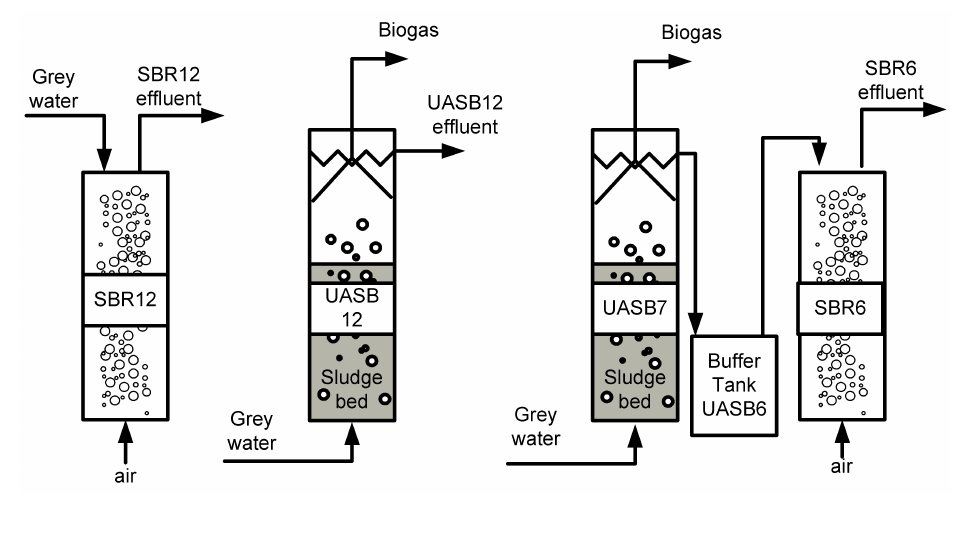
Figure 1. Lab-scale reactors set